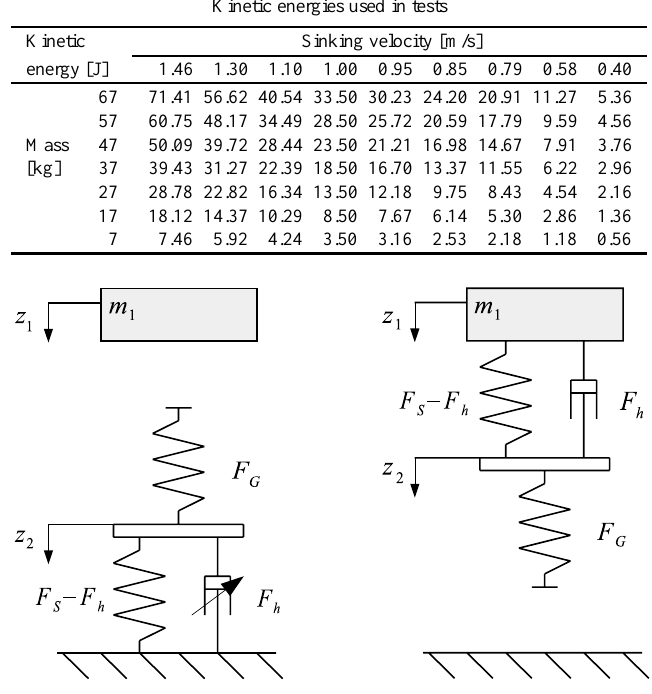
Fig. 18. Comparison of schemes of testing stands: (Left) lab-scale; (right)